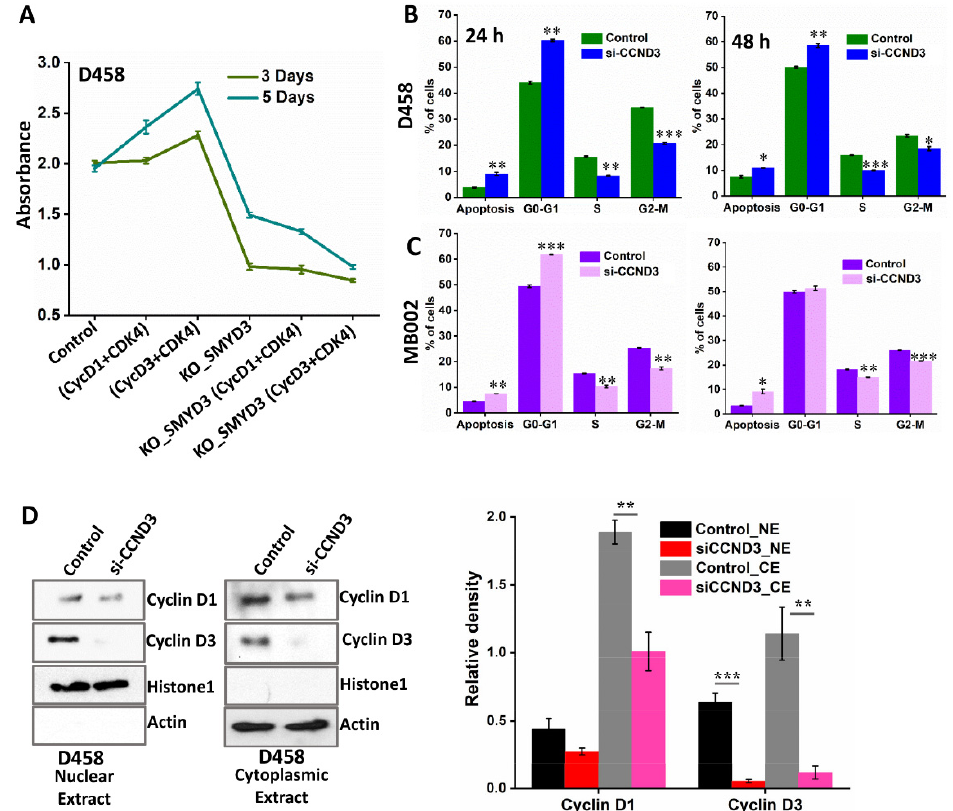
Figure 9. The effects of SMYD3 and cyclin D3 depletion on MB cell cytotoxicity. ( A ) MTT assay of D458 cells treated with cyclin D1/CDK4 or cyclin D3/CDK4 with or without SMYD3 knockout at 3 and 5 days. SMYD3 knockout (KO-SMYD3) CRISPR/Cas9 knockout all-in-one plasmids for specific deletion of three non-overlapping regions of SMYD3 (HCP260717-CG04-3-B) were used to treat D458 cells. ( B , C ) Bar graph depicting the percentage of control and siCCND3 treated D458 and MB002 cells in each phase of the cell cycle. ( D ) Western blot analysis of the nuclear extracts (NE) and cytoplasmic extracts (CE) obtained from the control and siCCND3 treated (48 h) D458 cells. Histone H1 and actin were used as the loading control for the NE and CE, respectively. Densitometry analysis for the cyclin D1 and D3 immunoblots of the NE and CE. The statistical significance * p < 0.05, ** p < 0.01, *** p < 0.001.